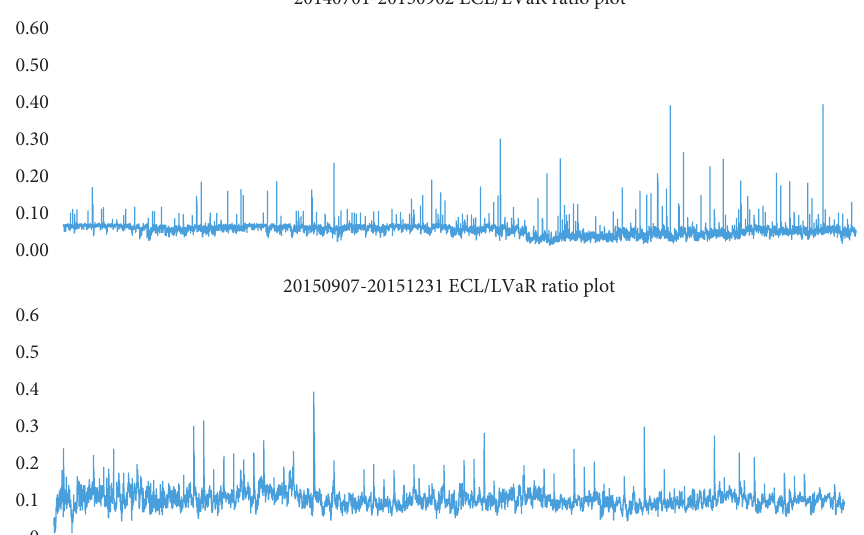
Figure 5: ECL/LVaR ratio chart before trade restriction of CSI 300 index futures (above) and after trade restriction (below) (minute